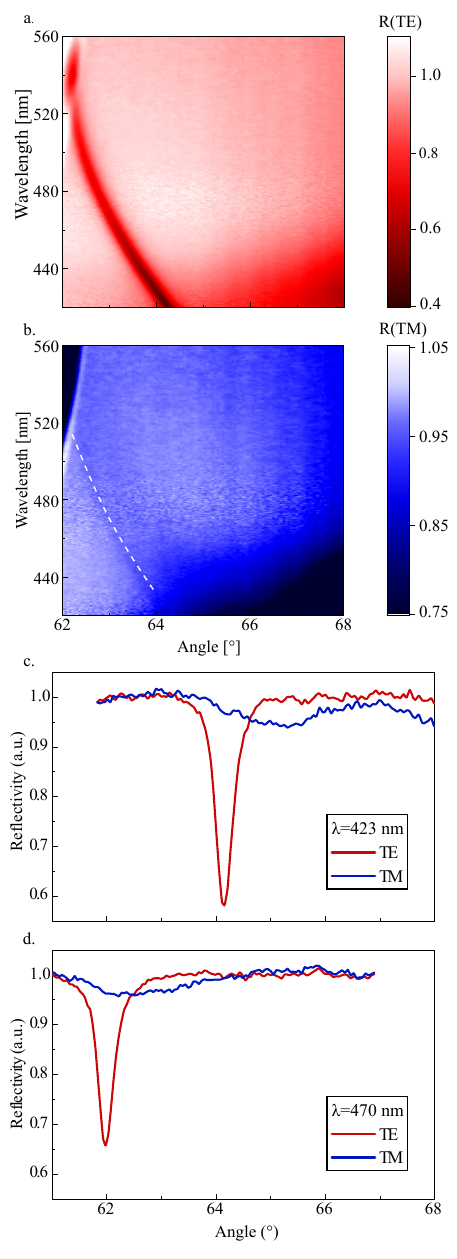
Figure 2. Experimental reflectivity (R) maps for a) TE illumination and b) TM illumination when the surface of the 1DPC is immersed in water. The dispersive TE and TM modes are visible as dips in the reflectivity maps. Experimental angular plot for a wavelength equal to c) 423 nm and d) 470